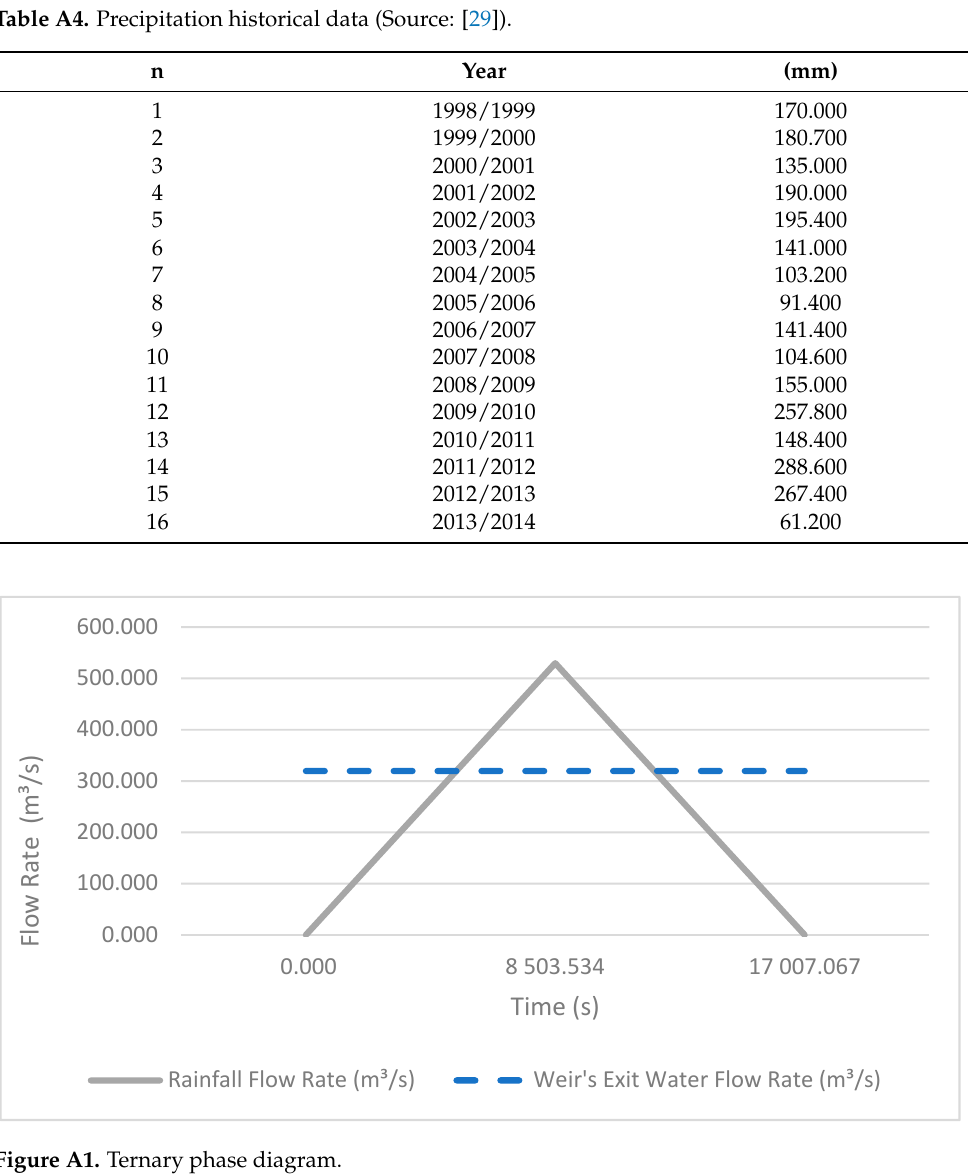
Figure A2. Expected rainfall for Ribeira Brava’s watershed. References 1.